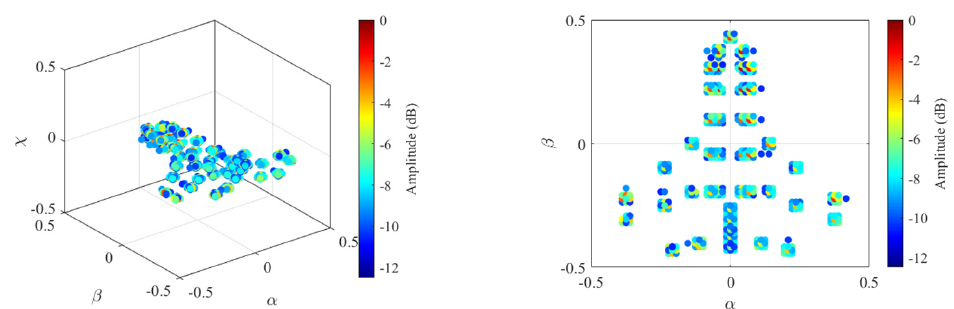
Figure 10. Target imaging result obtained by the 3D IFFT.